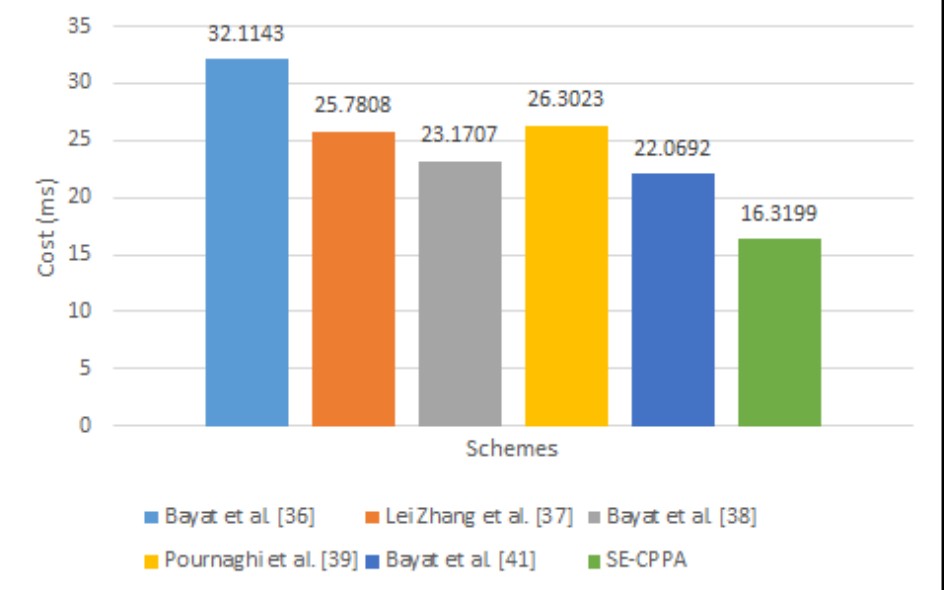
Figure 6. The comparison of single-signature verification